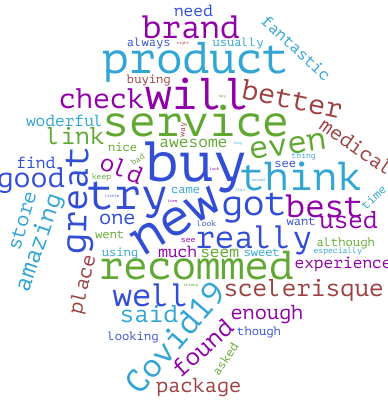
Figure 8. Word Cloud for spam reviews in different